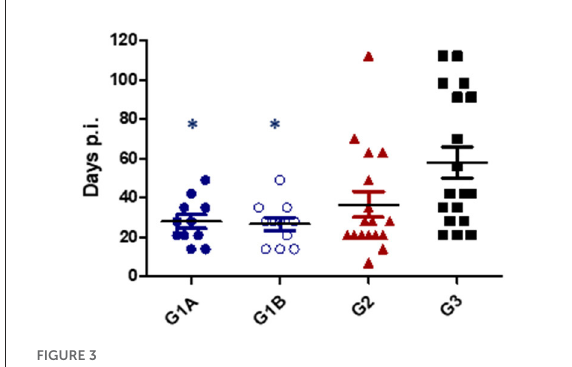
FIGURE3 Length of T. foetus infection in the genital tract. Immunized/challenged groups: Trichobovis administered by subcutaneous (SC; G1A) or intravulvar (IVU; G1B) routes and lines represent median values for each group. Asterisks indicate significant differences in G1A and G1B vs. G3.